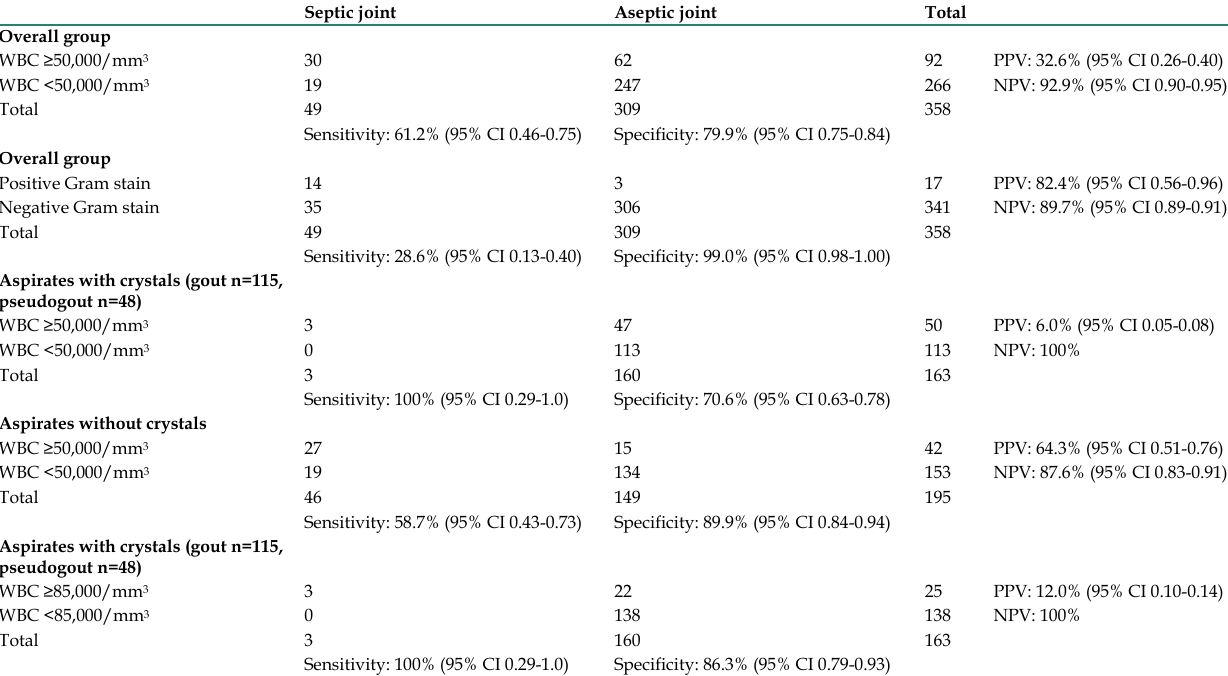
Table 3. Evaluation of synovial WBC count cut-off, gram stain, and presence of crystals in the diagnosis of septic arthritis. The sensitivity, specificity, positive predictive value (PPV), and negative predictive value (NPV) are presented for each test.